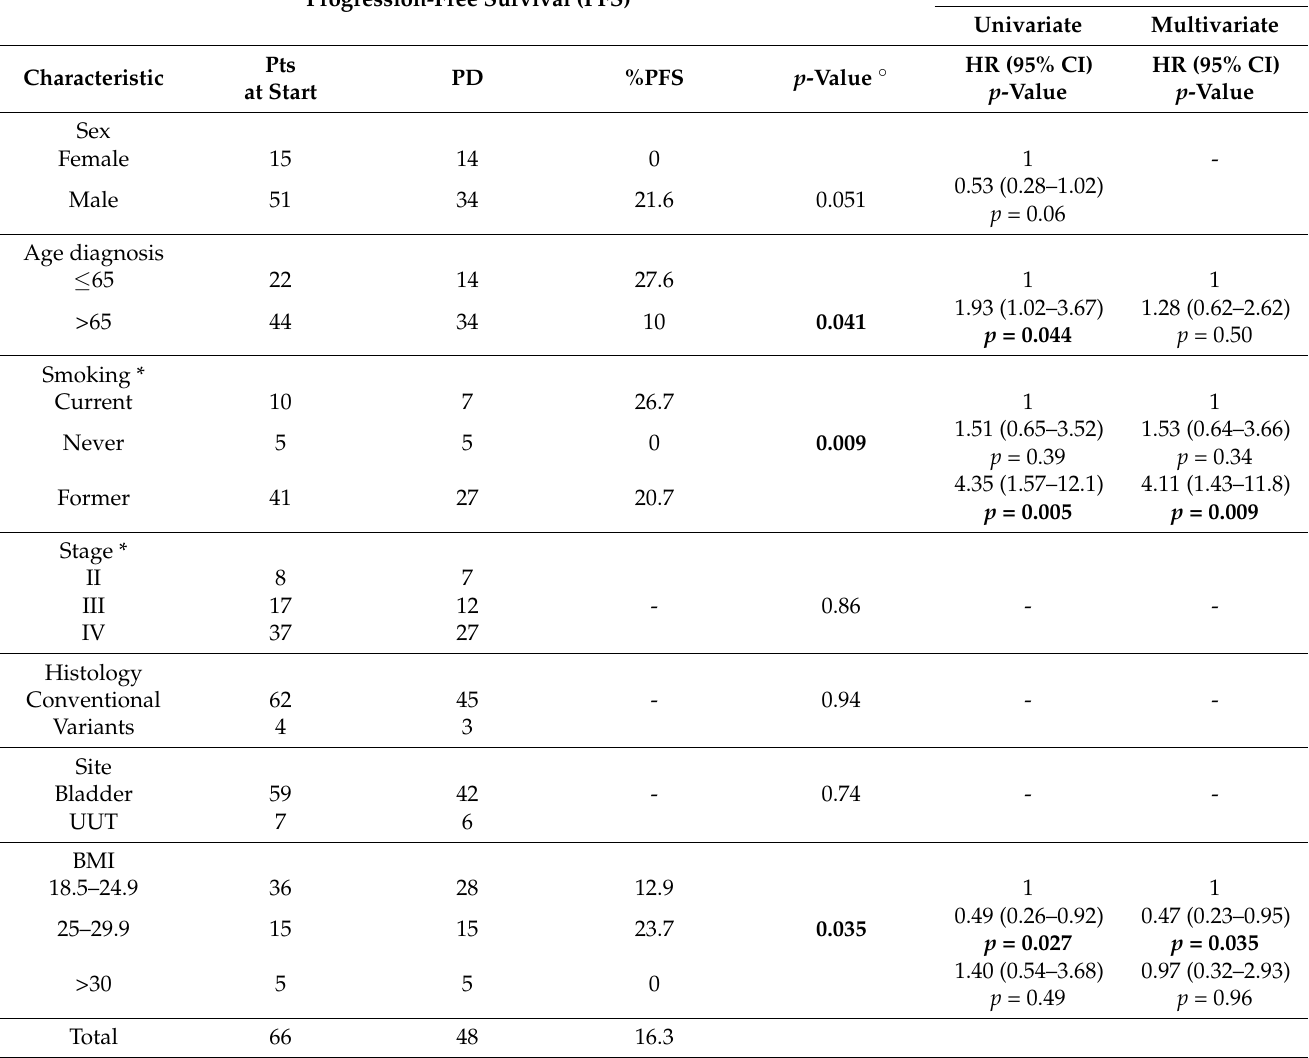
Table 3. Kaplan–Meier PFS survival analysis at approximately 70 months. HR and 95% CI from Cox Regression analysis (uni- and